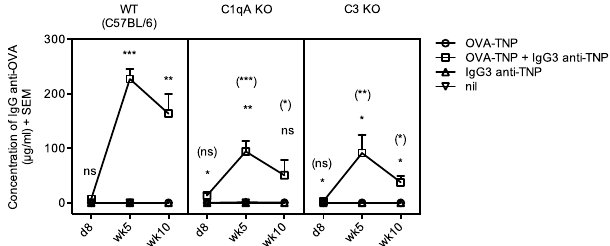
Figure 4. IgG3-mediated enhancement of antibody responses is impaired in mice lacking C1q or C3. WT (C57BL/6), C1qA KO, and C3 KO mice were immunized with 50 μ g IgG3 anti-TNP (IM-F10) alone (n = 1–2), 20 μ g OVA-TNP (n = 5), a mixture of 50 μ g IgG3 anti-TNP (IM-F10) and 20 μ g OVA-TNP (n = 5), or left untreated (nil; n = 1–2). Mice were bled at indicated time points. Sera were diluted 1:25 (in antigen, IgG3 alone, and nil groups), or 1:3125 (in IgG3 + antigen-group), and screened for OVA-specific IgG in ELISA. Comparisons between WT and C1qA KO mice were done in 3 experiments and between WT and C3 KO mice in 2 experiments and a representative experiment is shown. The p values for comparisons of the responses in mice immunized with antigen alone or IgG3-antigen complexes are indicated without parentheses. The p values for comparisons of responses in WT versus C1qA or C3 KO mice immunized with IgG3-antigen complexes are indicated within parentheses. ns, p > 0.05; * p < 0.05; ** p < 0.01; *** p <